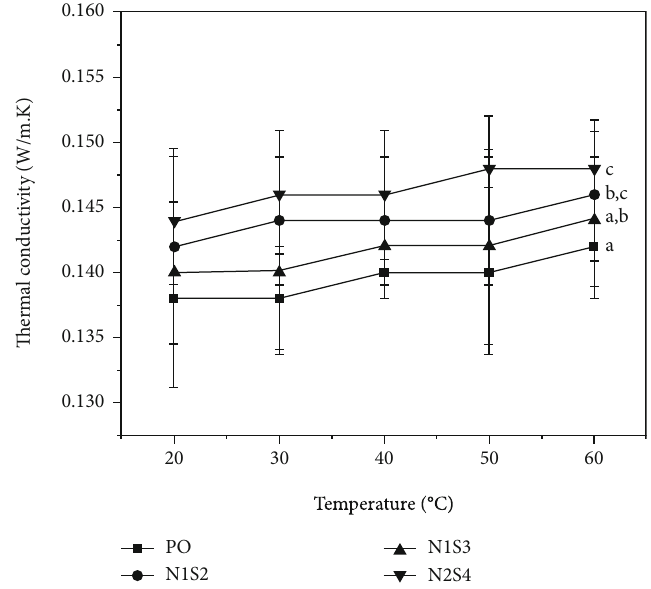
Figure 4: Thermal conductivity of PO and biolubricants. Di ff erent subscripts (a, b, c) indicate signi fi cant di ff erences at p ≤ 0 : 05 .